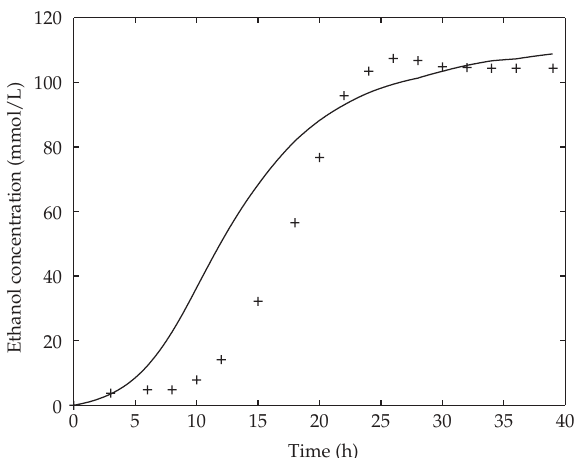
Figure 6: Comparison of ethanol concentration between experimental data and computational